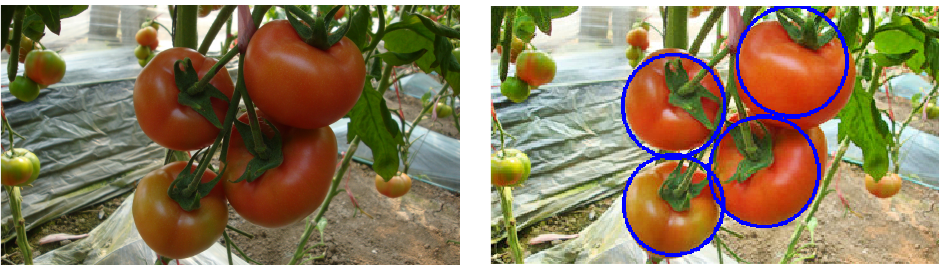
Figure 15. An example of the detection results under different lighting conditions: ( a ) sunny conditions and ( b ) shaded